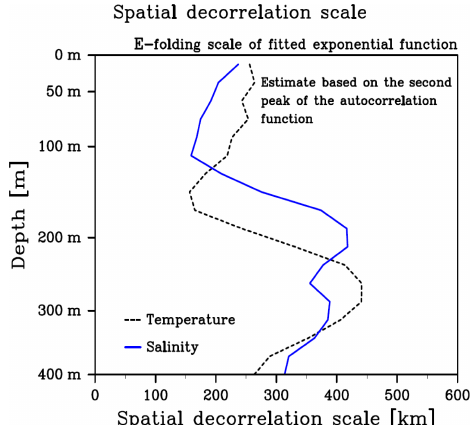
Figure C1. Vertical profile of the spatial decorrelation scales esti- mated from the second peak of the spatial autocorrelation function (see Fig. 10a, b). The scale is obtained from a Gaussian function fitting with two points: zero-lag autocorrelation value from Fig. 12a and the second peak. The second peak is defined by the highest au- tocorrelation value, the spatial lag of which is larger than 150km. A three-layer vertical filter is applied to eliminate